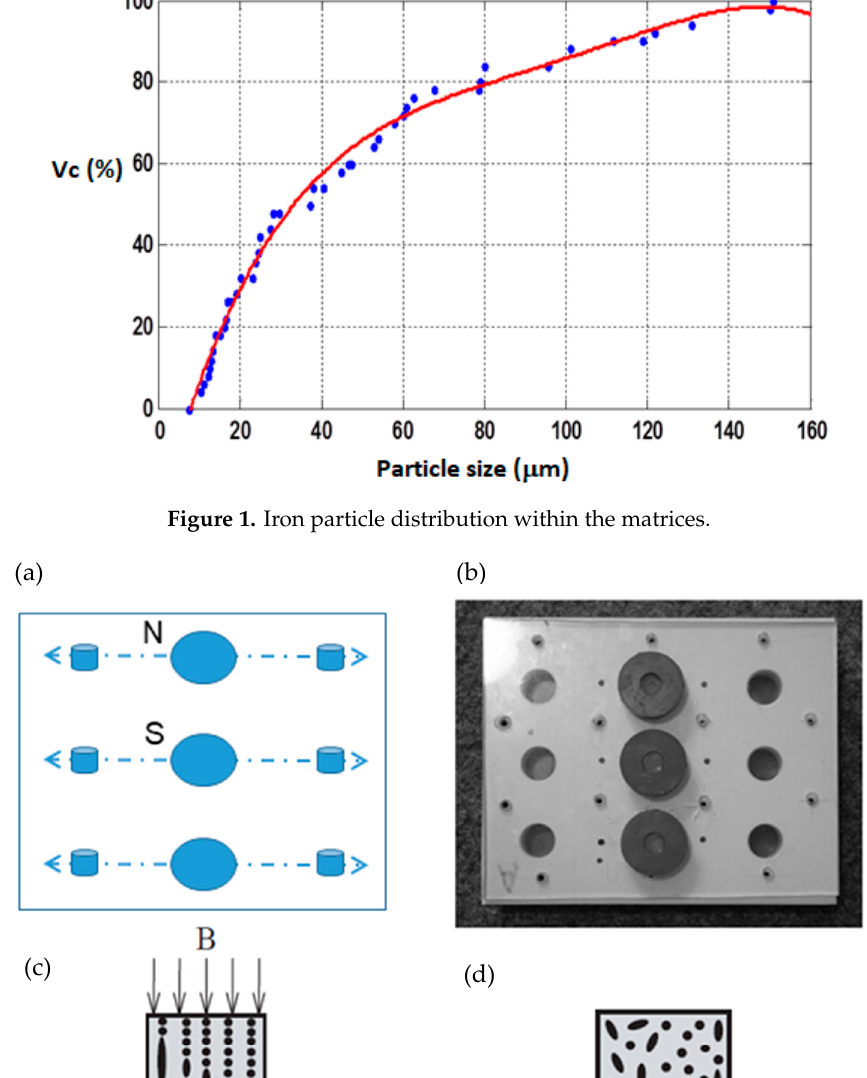
Table 1. Composition and polarizable character of the magnetorheological elastomer (MRE) 100